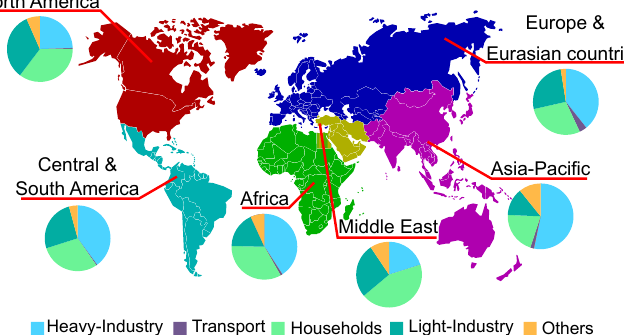
Figure 1. Electricity final consumption by sectors and regions.